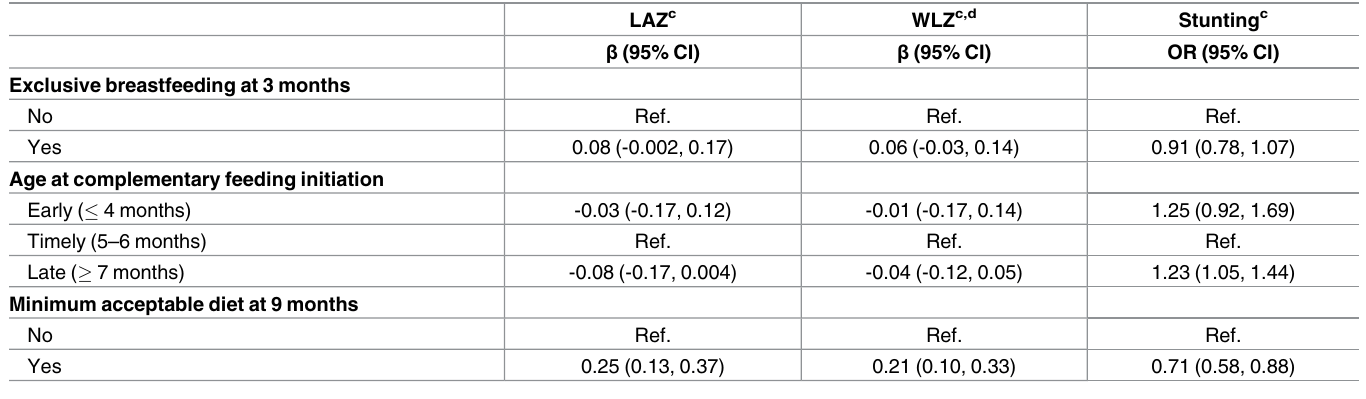
Table 4. Association between infant feeding practices and infant nutritional status a in Kishoreganj, Bangladesh–results from GEE models b